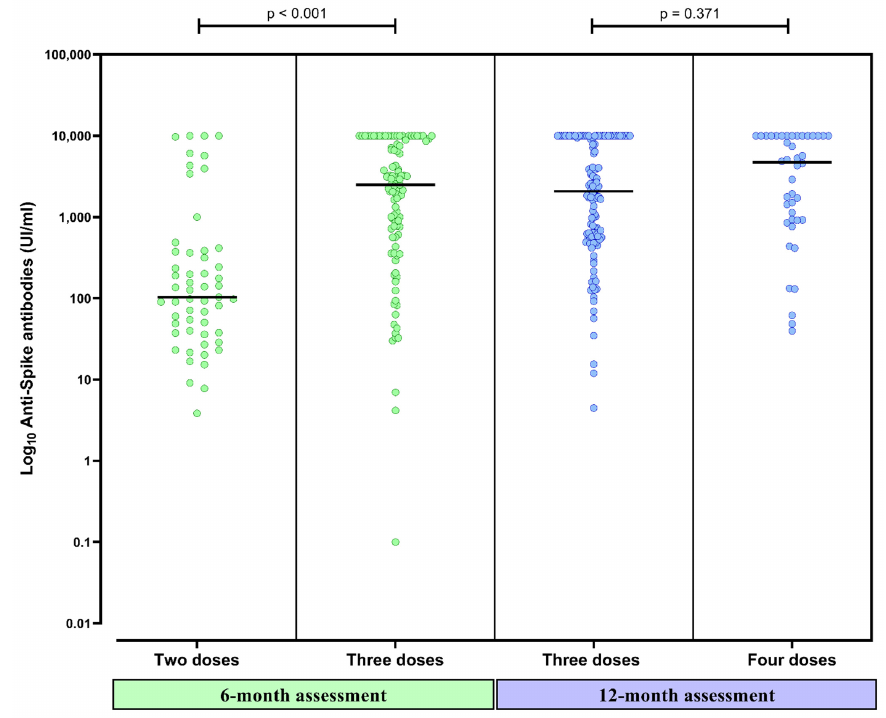
Figure 3. Anti-spike antibody titers 6 months after completing the initial vaccine schedule in CKD patients on peritoneal dialysis who had received two and three doses of SARS-CoV-2 vaccines and titers 12 months after completing the initial vaccine schedule in patients with three and four doses. The black line represents the median value of each strata.